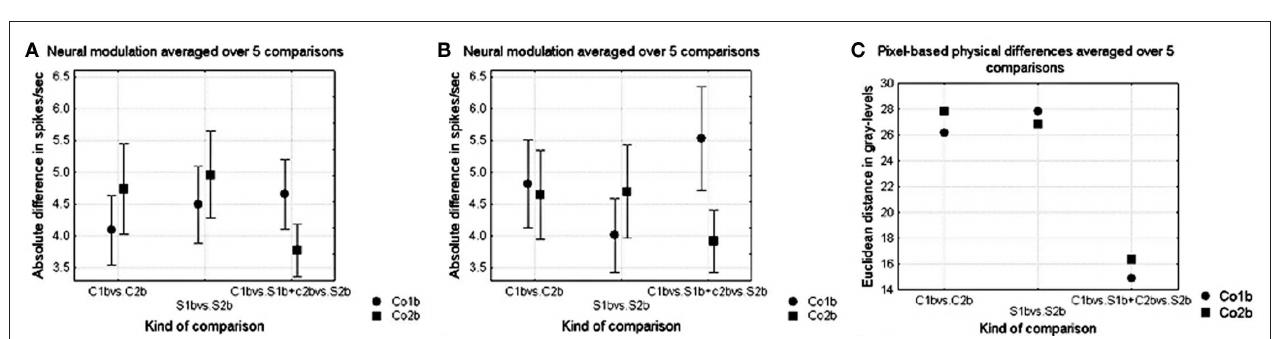
and Co2b). Curved versus straight comparisons were first averaged within the rows (according to the formula: (|C1 − S1| + |C2 − S2|)/2, thus also their standard errors are on five data points. Vertical bars denote standard errors. (A) Shows the neural modulation for the small size versions of the shapes and (B) the neural modulation for the large versions. (C) Pixel-based dissimilarities for the different kinds of